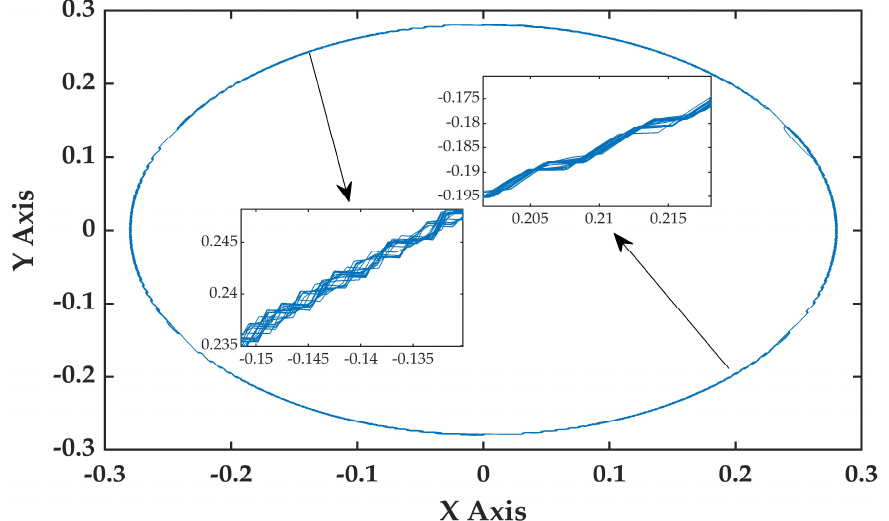
Figure 13. Flux track of the IESO−CFDL−MFAPC controller.